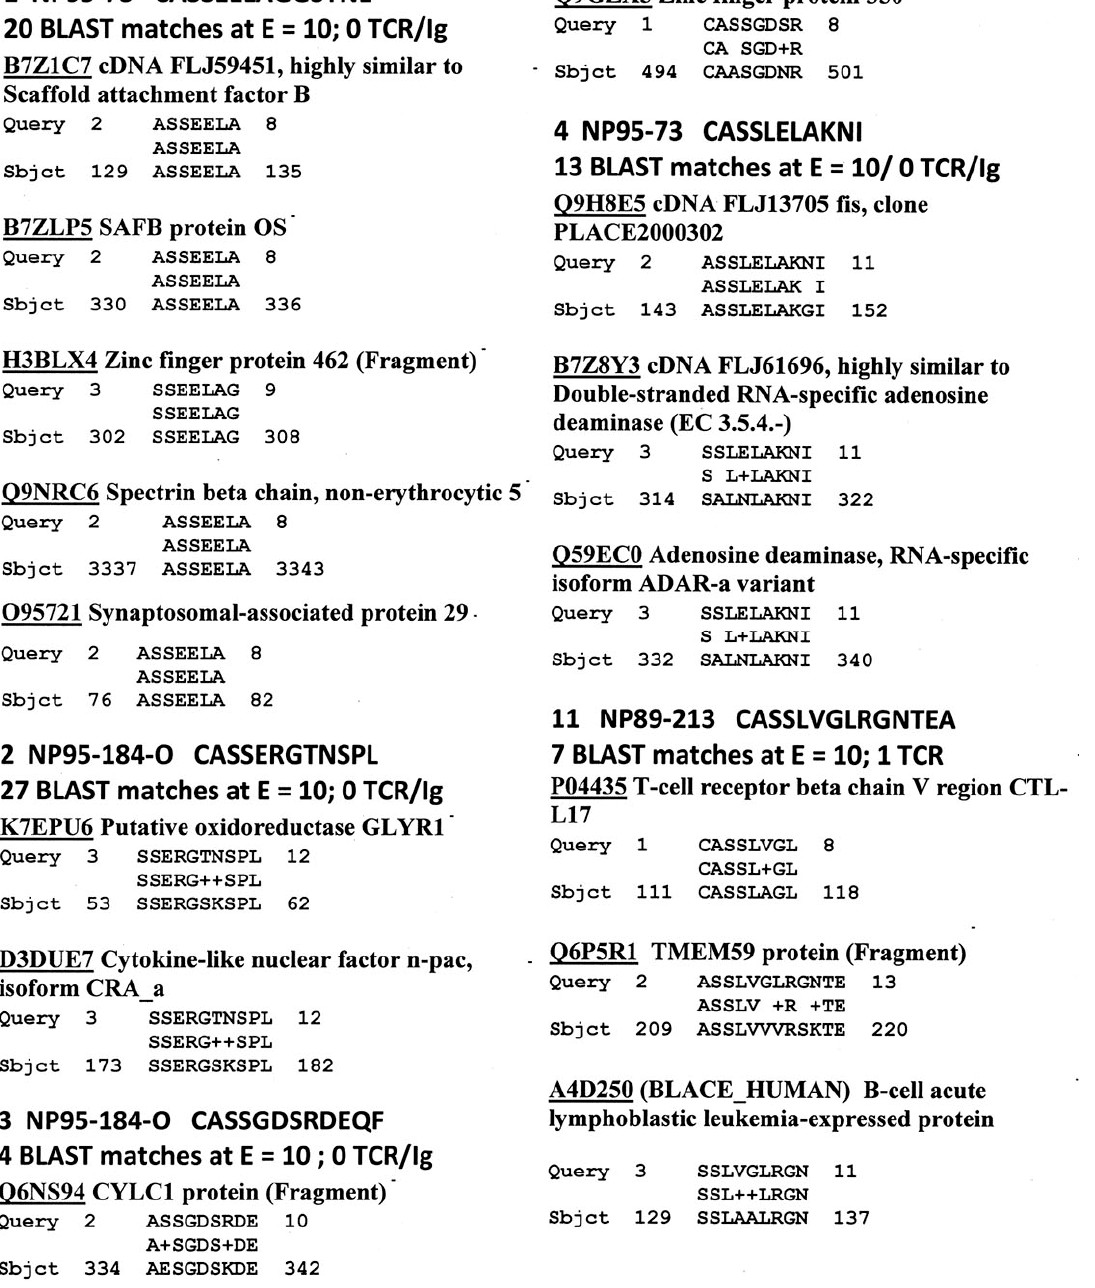
Figure 3. Selected examples of HIV TCR-Human protein similarities (BLAST search, E = 10, no gaps). See Figure 6 for examples. Accession numbers refer to the UniProt protein database (www.expasy.org). Table 4. Frequency with which HIV TCR mimic human proteins (see Figure 3 for examples). The number of matches is provided plus or minus the standard deviation for total human protein similarities; for the subset of other TCR and immunoglobulins; and for the subset of somatic proteins.